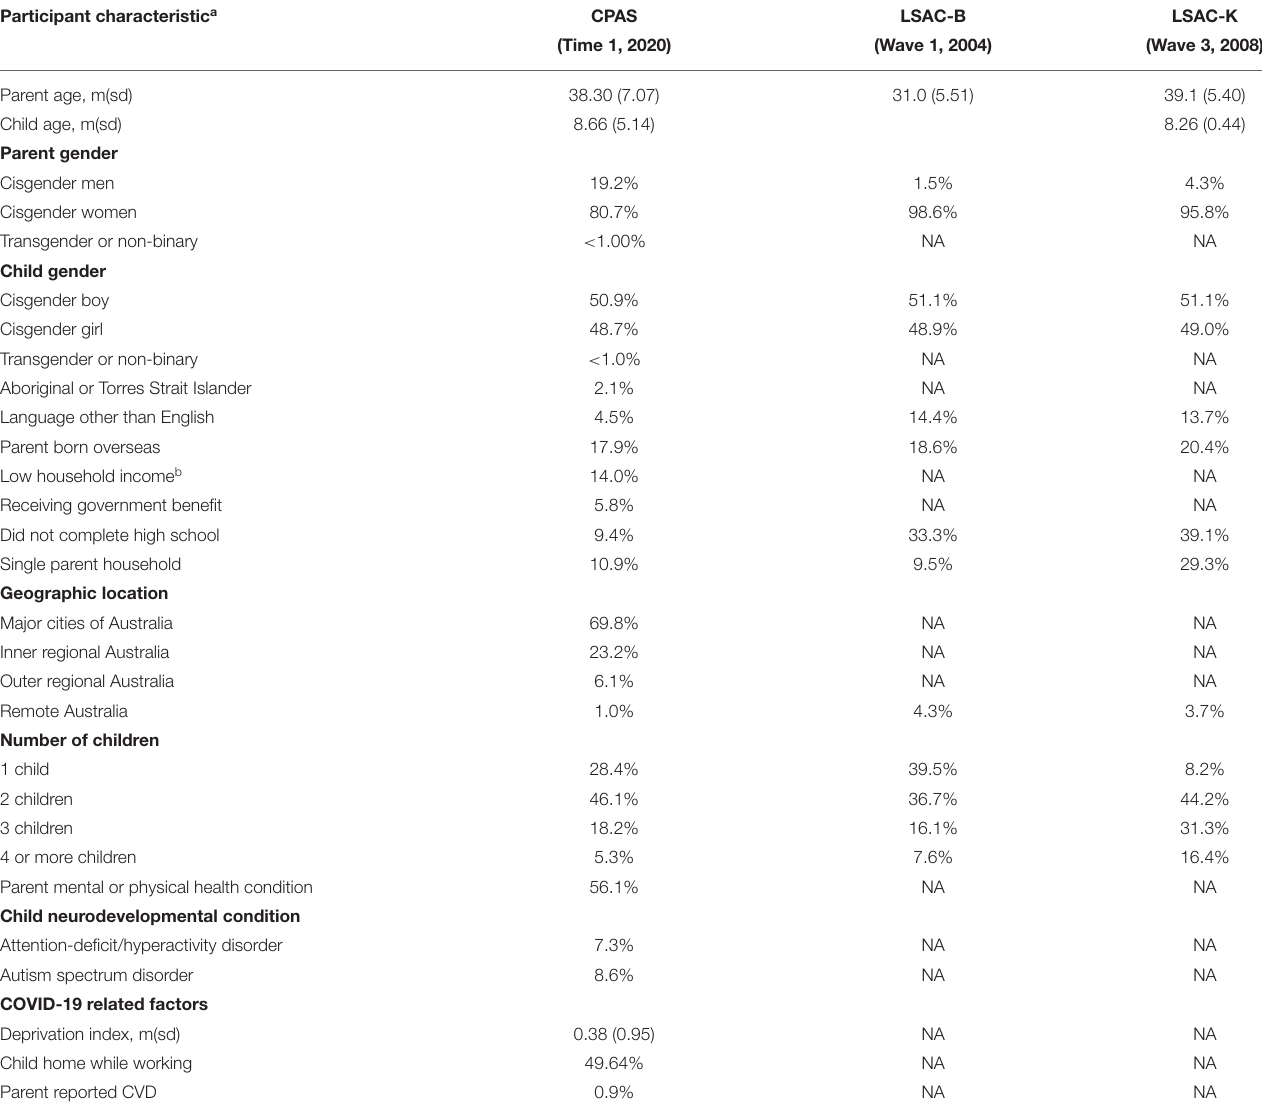
TABLE 2 | Participant characteristics in the COVID-19 Pandemic Adjustment Survey ( N = 2365, child aged 0–18 years) and the Longitudinal Study of Australian Children Baby Cohort (Wave 1, N = 5,107) and Kindergarten Cohort (Wave 3, N = 4,331). Participant characteristic